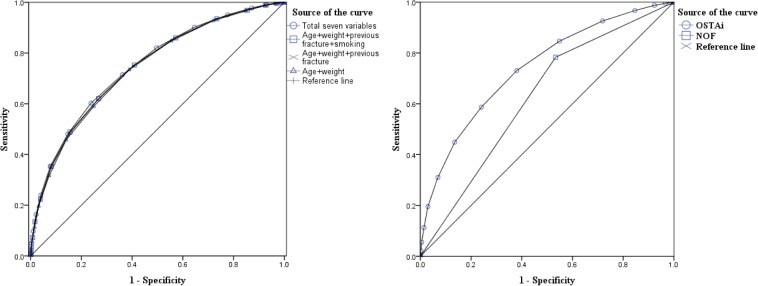
The ROC curves for comparison.(a)The ROC curves for final model variables. ROC curves of two-variable model (age and weight), three-variable model, four-variable model, and total seven variables in predicting osteoporosis (b)The ROC curves for the OSTAi index and NOF 2013 recommendations.